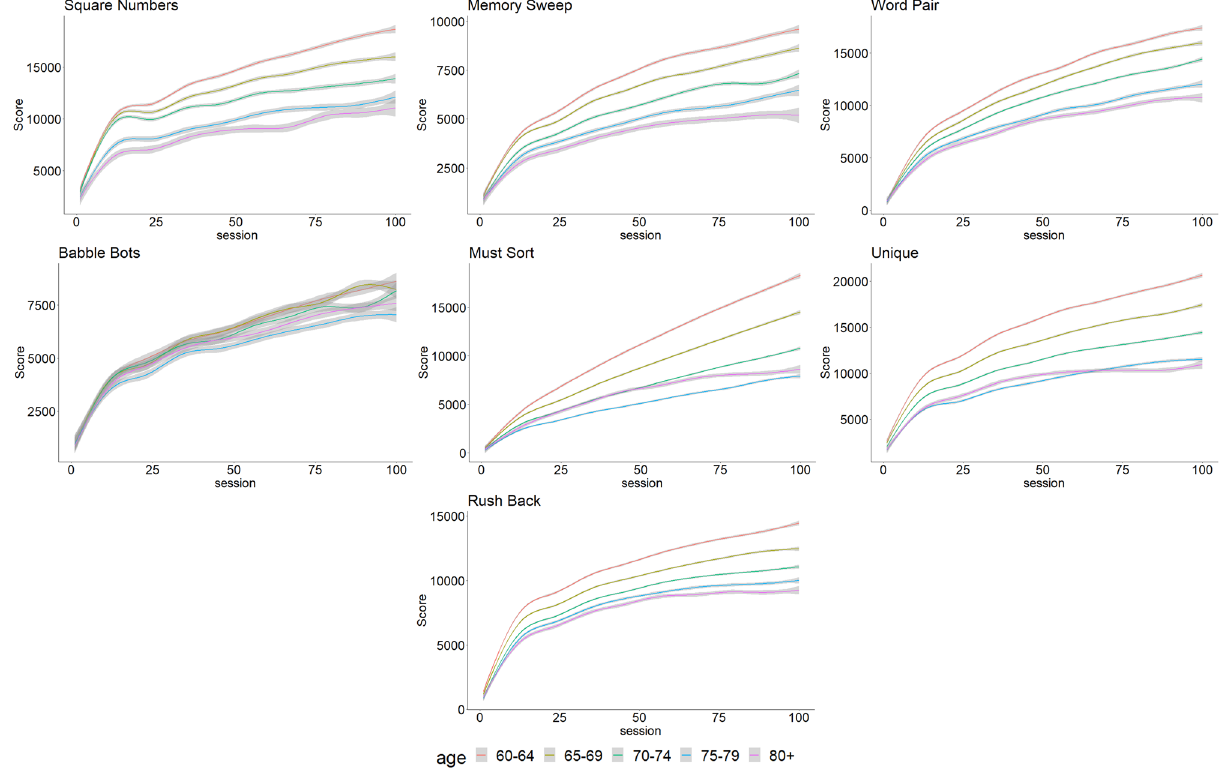
Figure 1. Time course of the scores for the 7 different CMG over the 100 sessions, grey bands are the 95% CI.